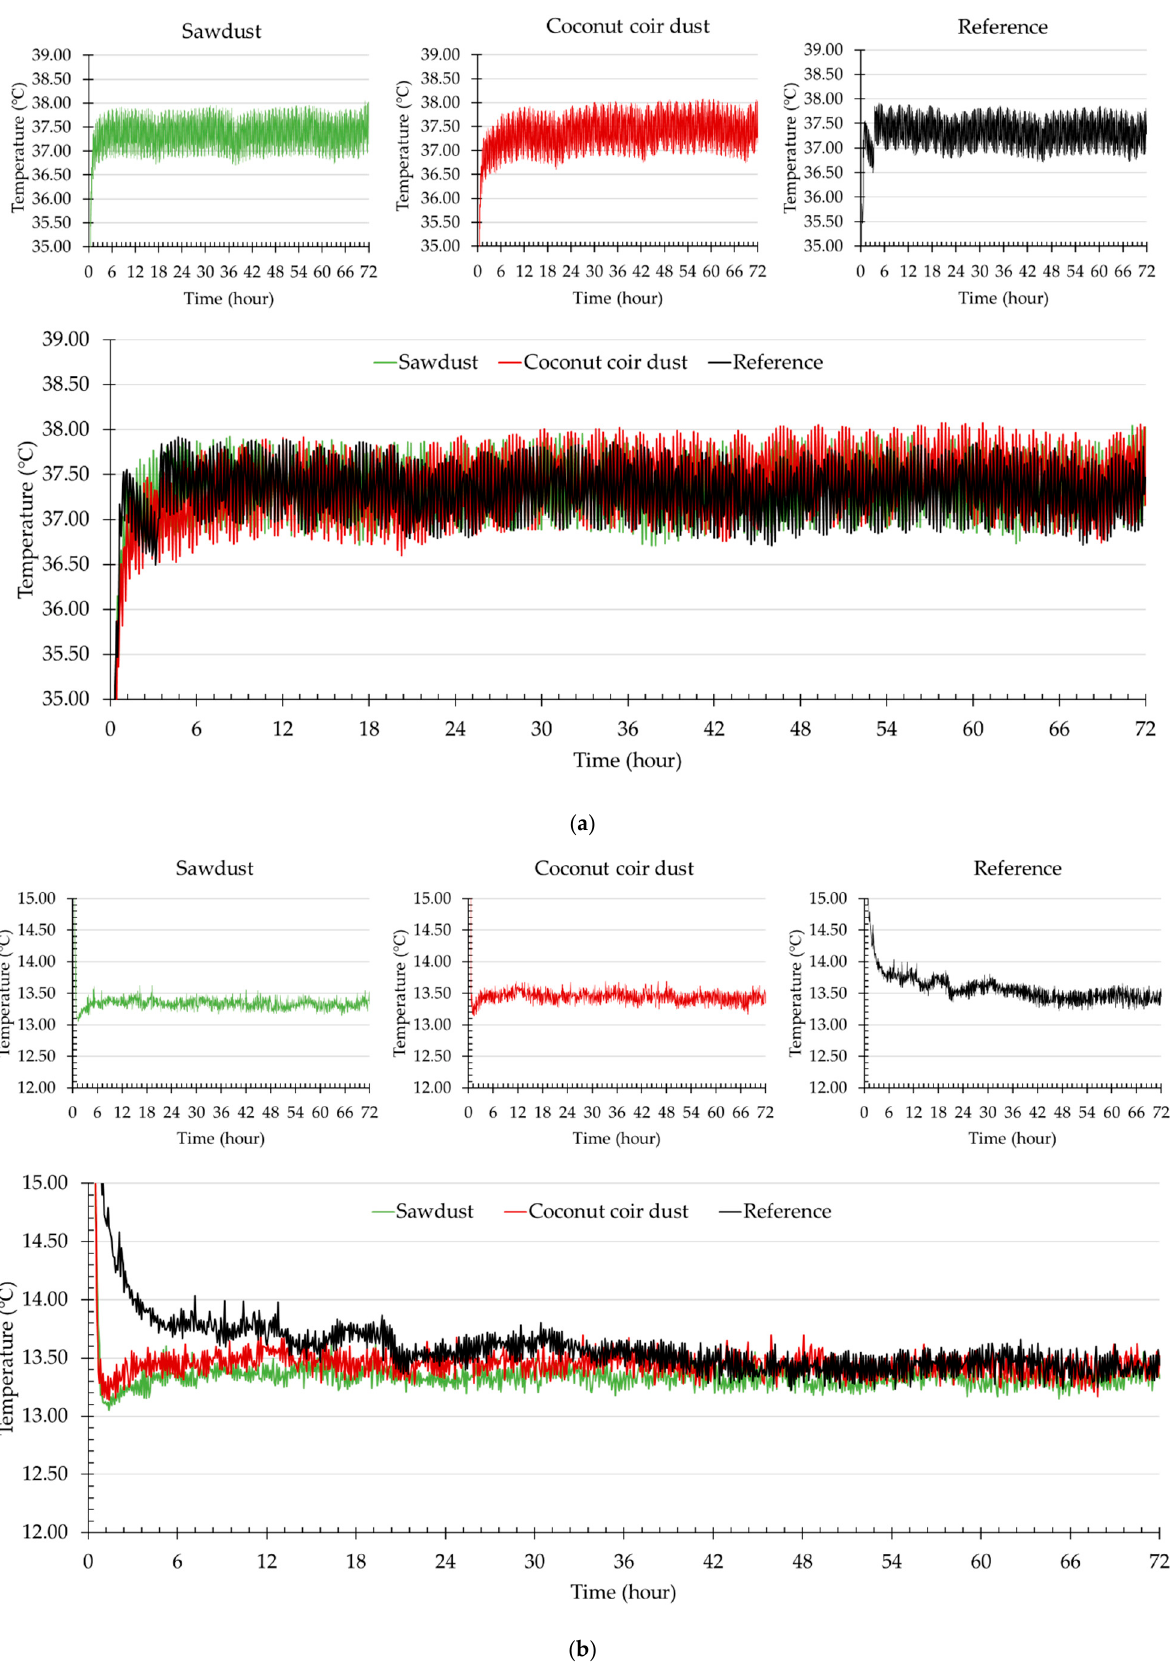
Figure 10. Wall surface temperature profiles (72 h): ( a ) hot side; ( b ) cold side.